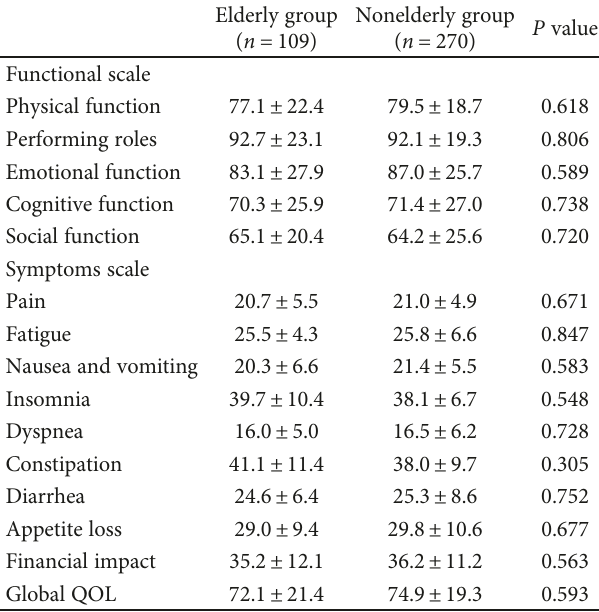
Table 5: The EORTC QLQ-C30 scores between elderly and nonelderly